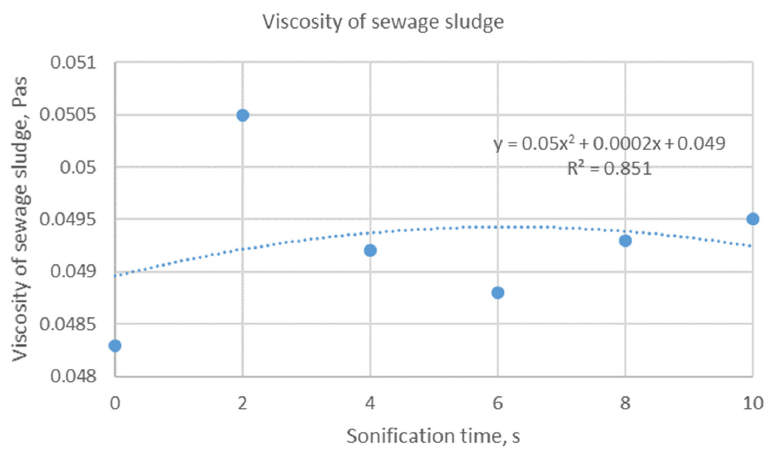
Figure 4. Viscosity of polyelectrolyte after ultrasonic field action.